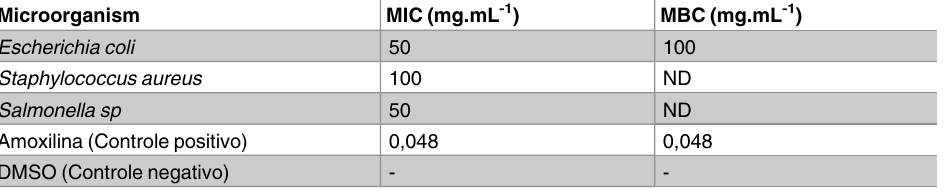
Table 4. Minimum Inhibitory Concentration (MIC) and Minimum Bactericidal Concentration (MBC) of the essential oil Aeollanthus suaveolens .